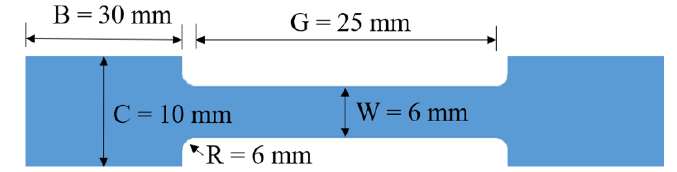
Figure 2. Size details of the samples for tensile test.